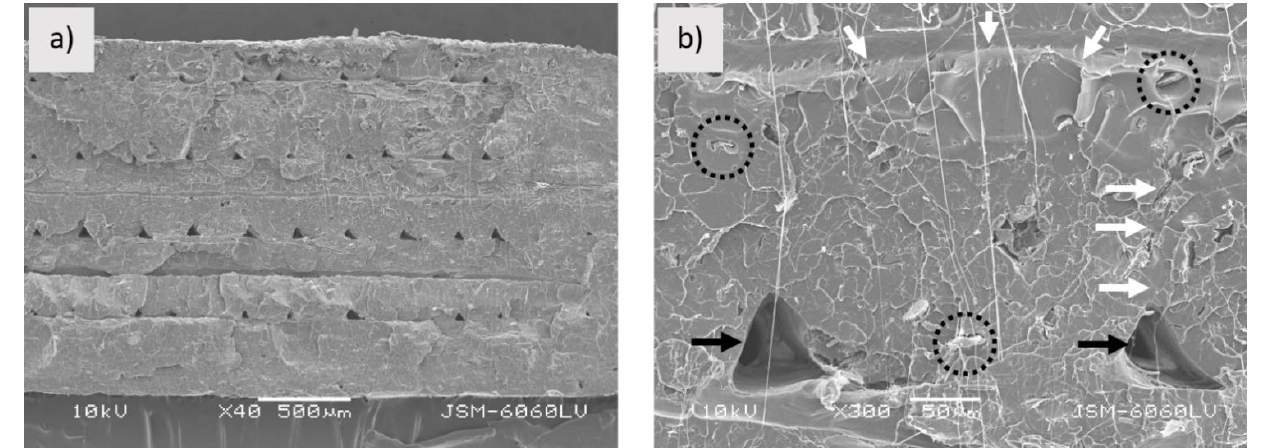
Figure 6. Sample PLA-Entwined_3D; ( a ) fractured surface of sample (mag. 40×), ( b ) fractured surface of print filament (white arrows indicate area where two printed filaments and layers are firmly connected; black arrows point to empty space; dotted circles show embedded hemp fibres) (mag. 300×).